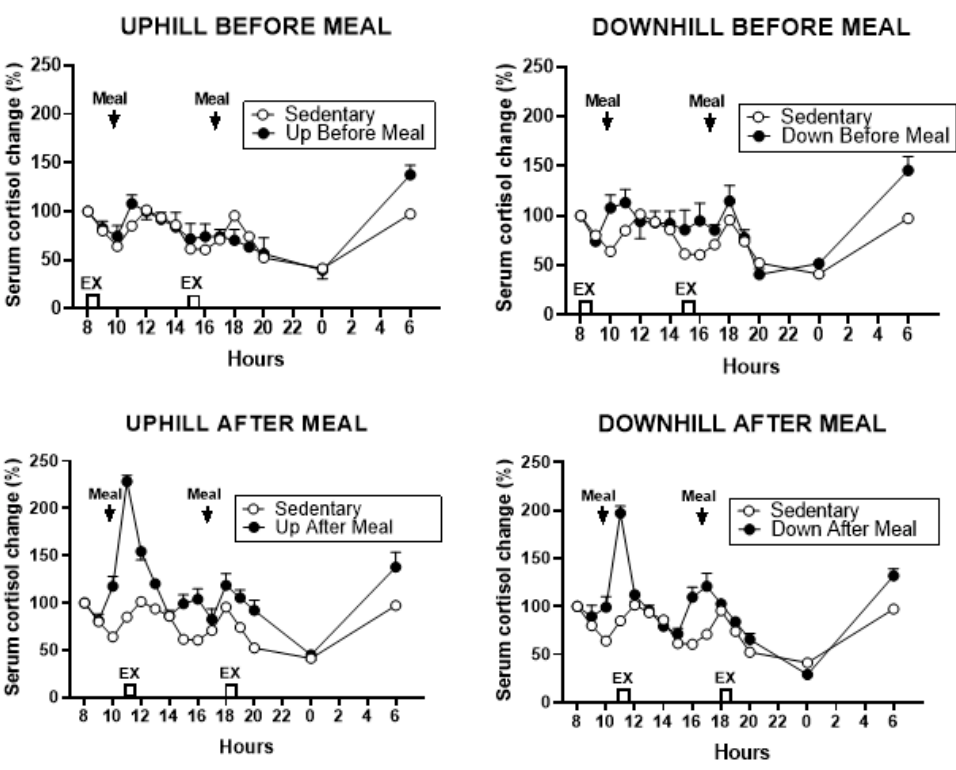
Figure 13. Percent changes in serum cortisol between sedentary trial and exercise-before-meal trials is shown at the top (left: UBM, right: DBM), and after exercise trials performed after eating, is shown at the bottom (left: UAM, right: DAM).